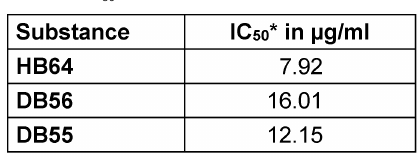
Table 2: Toxicity of